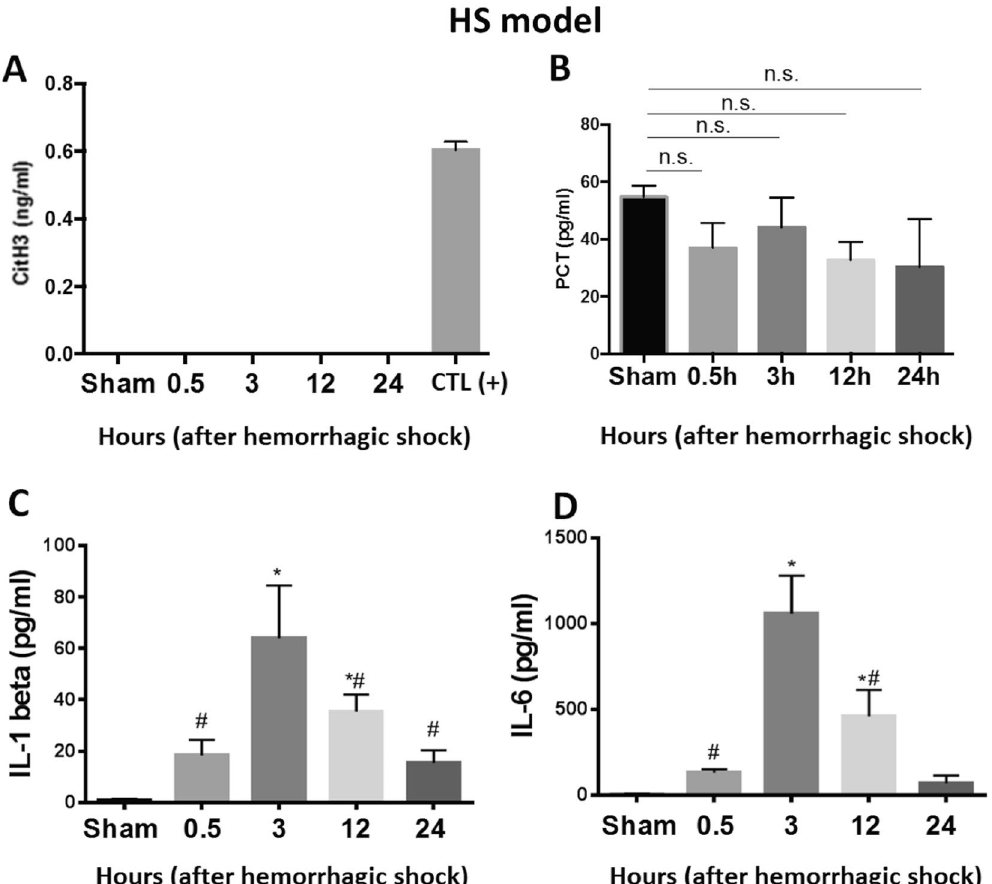
Figure 4. CitH3 is a specific biomarker to distinguish LPSS from HS. Mice were subjected to HS (30% hemorrhage without resuscitation) and blood samples were collected at 0.5, 3, 12, and 24 hours after HS for detection of CitH3 ( A ), PCT ( B ), IL-1 β ( C ) and IL-6 ( D ) by ELISA. Animals from Sham group received all procedures except cannulation and hemorrhage. CitH3 protein serves as a positive control in panel A. No circulating CitH3 was detectable by ELISA. HS did not alter the blood concentration of PCT compared to Sham group. Pro-inflammatory cytokines (IL-1 β & IL-6) elevated greatly compared to Sham. Data are shown as mean ± standard deviation (SD). (n = 3–5/group). IL-1 β : interlukine-1 β ; IL-6: interlukine-6; CitH3: Citrullinated histone H3; LPS: Lipopolysaccharide; DMSO: dimethyl sulfoxide. PCT: procalcitonin; HS: hemorrhagic shock. CTL ( + ): positive